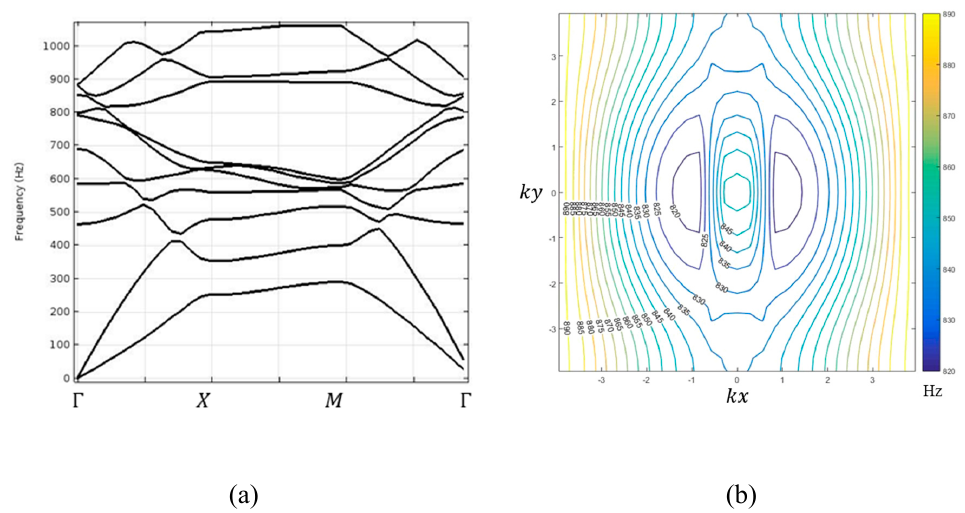
Figure 7. The numerical results of the wave propagation of the phononic crystals composed of inclusions with rectangular cross section and star-shaped honeycomb matrix. ( a ) the band structures; ( b ) the equi-frequency contour of the 8th band. The star angle is 𝜃 = 55° , Poisson’s ratio of the matrix is ν = − 0 . 53. The geometric parameters of the inclusions are 𝑤 = 14𝑎/15 , ℎ = 𝑎/5 and 𝜙 = 0° .